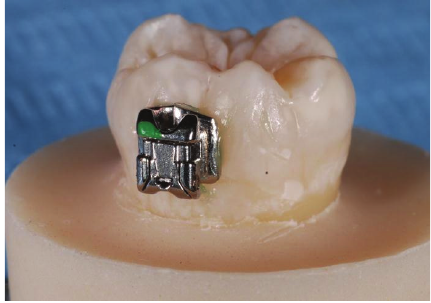
Figure 4: Bracket bonded on the enamel.